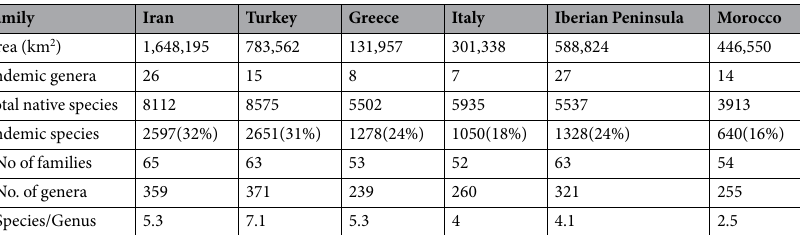
Table 2. Comparison of area size, total species richness and degree of endemism in the vascular flora of Iran versus other Mediterranean regions (Turkey, Greece, Italy, Iberian Peninsula, Morocco; data from Buira, et al . 40